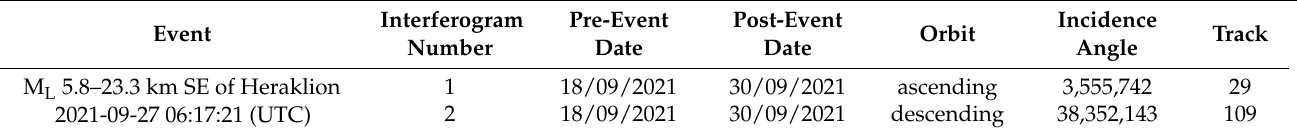
Table 2. Sentinel-1 images used for InSAR processing of M L 5.8 Central Crete